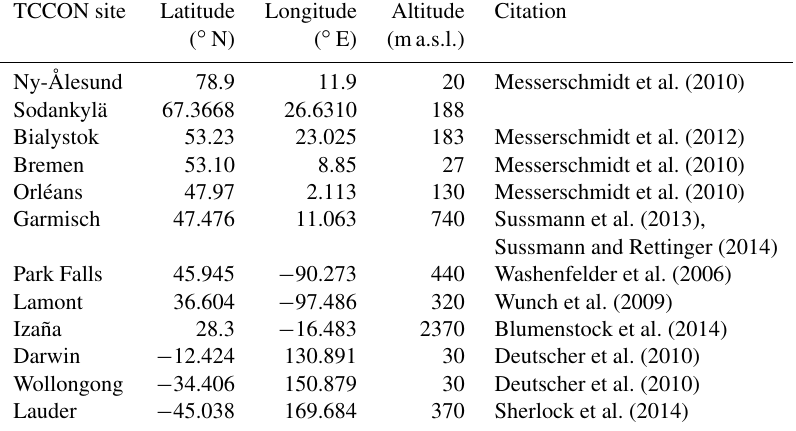
Figure 1. Calibration results of FTS-derived tropospheric column-averaged CH 4 mole fractions against in situ measurements. The in situ profiles are smoothed using GFIT CH 4 averaging kernels in the troposphere as described in Wang et al. (2014). The FTS data are averaged for the in situ measurement periods. The IMECC is an aircraft campaign over Europe (Geibel et al., 2012). The Lamont-AirCore measurements are from Greenhouse Gas Group Aircraft Program (http://www.esrl.noaa.gov/gmd/ccgg/aircraft/). The AirCore data at Sodankylä is from the FTS group there. Table 1. Overview of TCCON sites used. TCCON site Latitude Longitude